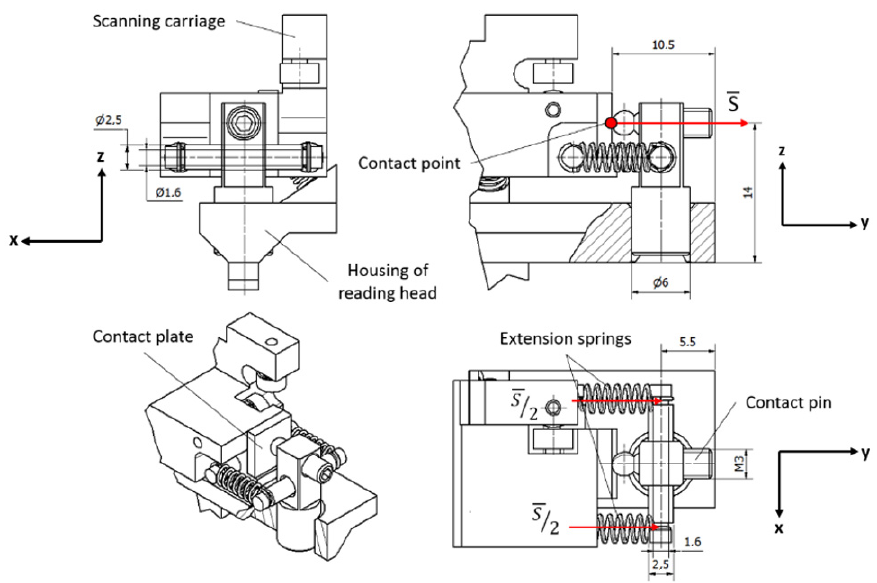
Figure 10. Mechanical construction of contact pair C.